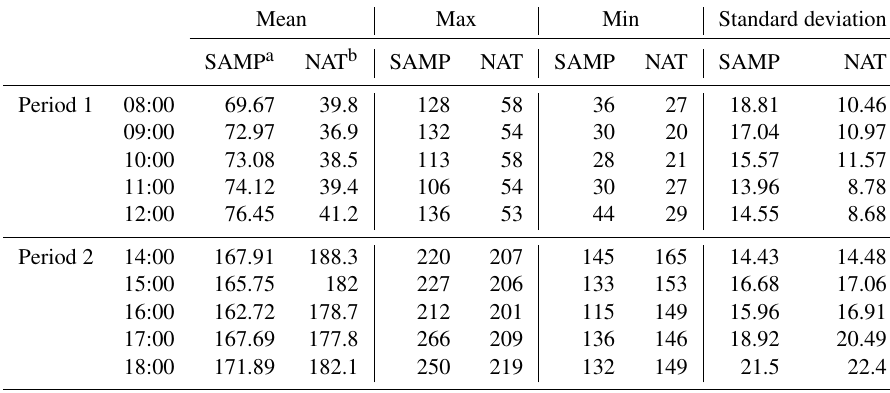
Table 3. Descriptive statistics of PM 2 . 5 concentration (µgm − 3